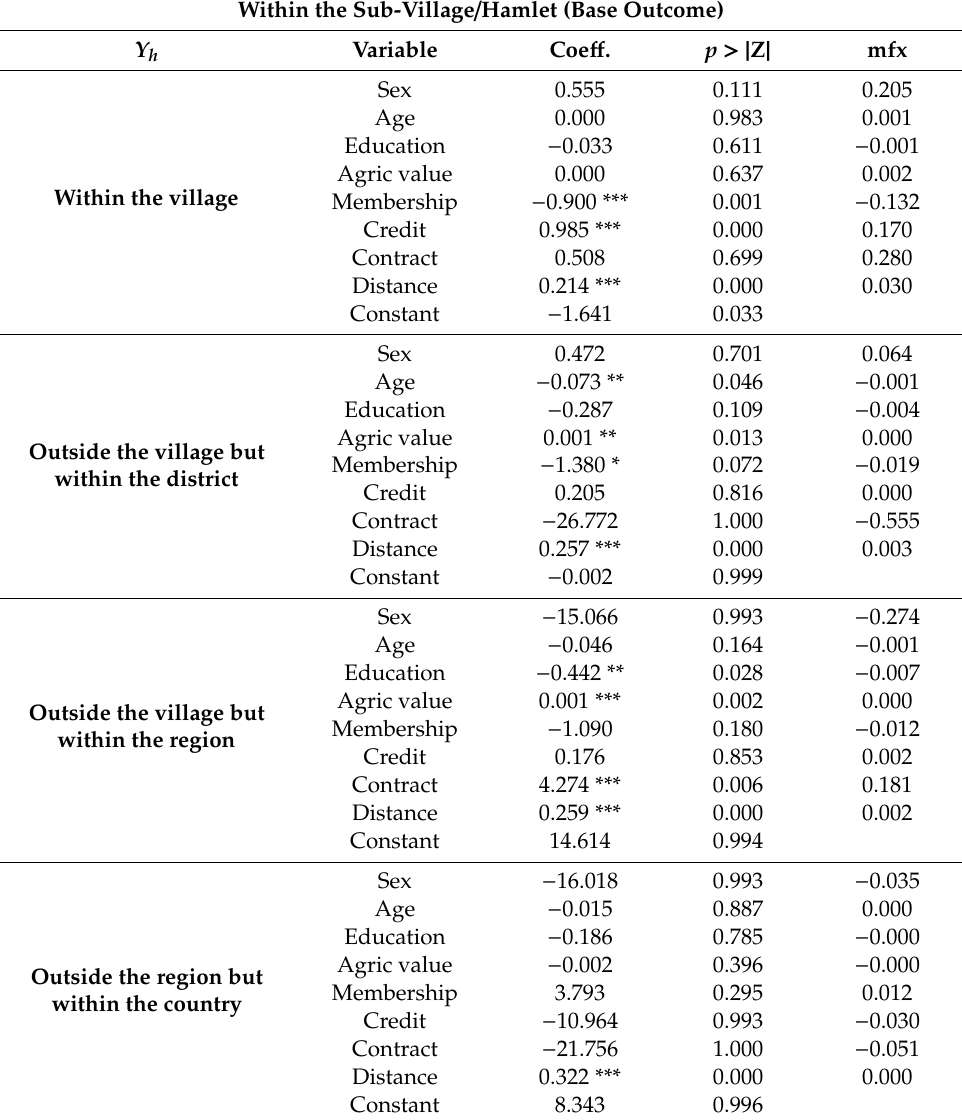
Table 5. Determinants of farmers’ choice of